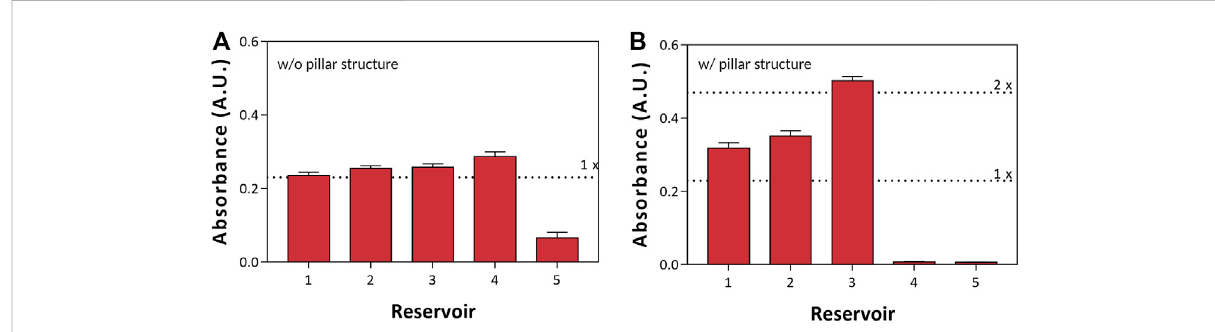
FIGURE 5 Preconcentration measurements of Orange-G with a spectrophotometer. (A) Without and (B) with a pillar-structured channel.